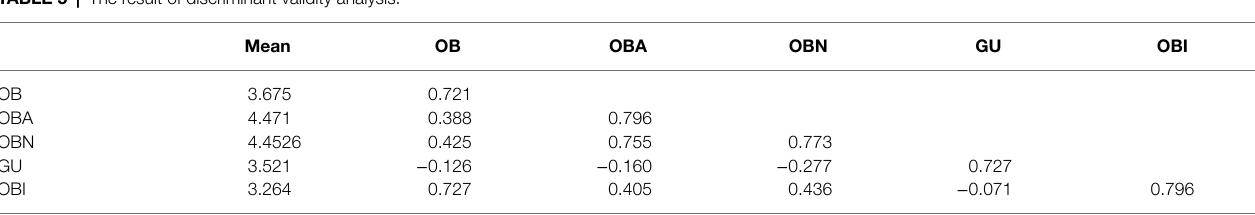
TABLE 5 | The result of discriminant validity